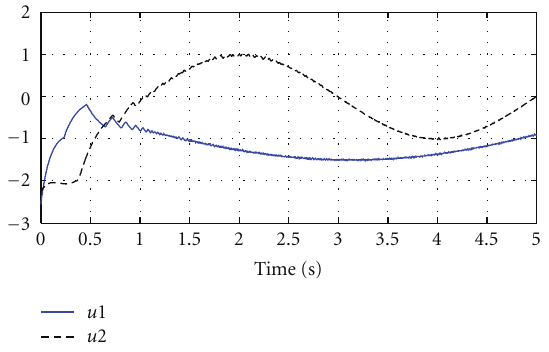
Figure 7: Control inputs with applying the proposed method.